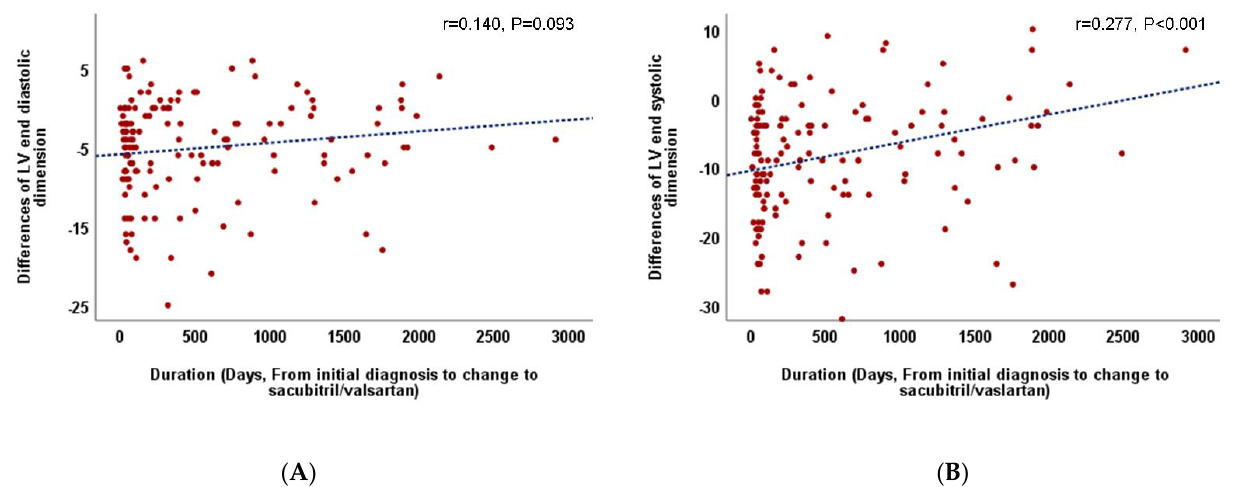
Figure 3. ( A ). Correlation between the duration from the initial diagnosis to the change to sacubitril/valsartan and left ventricular end-diastolic dimension. ( B ). Correlation between the duration from the initial diagnosis to the change to sacubitril/valsartan and left ventricular end-systolic dimension. Table 5. Univariate and multivariate analyses for cardiac events during entire